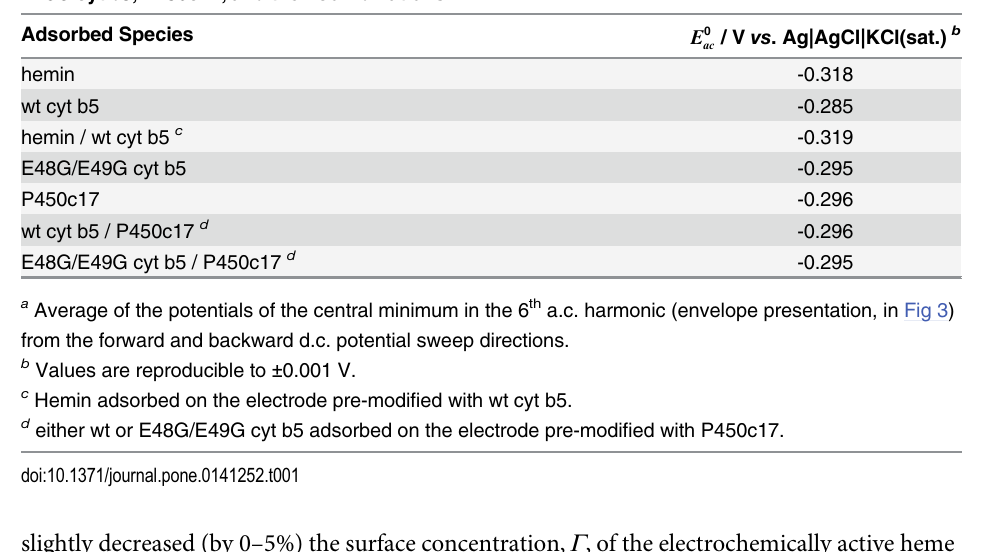
Table 1. Reversible potentials ( E 0 ac ) of the surface con fi ned Fe 3+/2+ redox couple derived from the a.c. voltammograms ( f = 219 Hz) a obtained from CNT electrodes modi fi ed with hemin, wt cyt b5, E48G/ E49G cyt b5, P450c17, and their combinations. Adsorbed Species